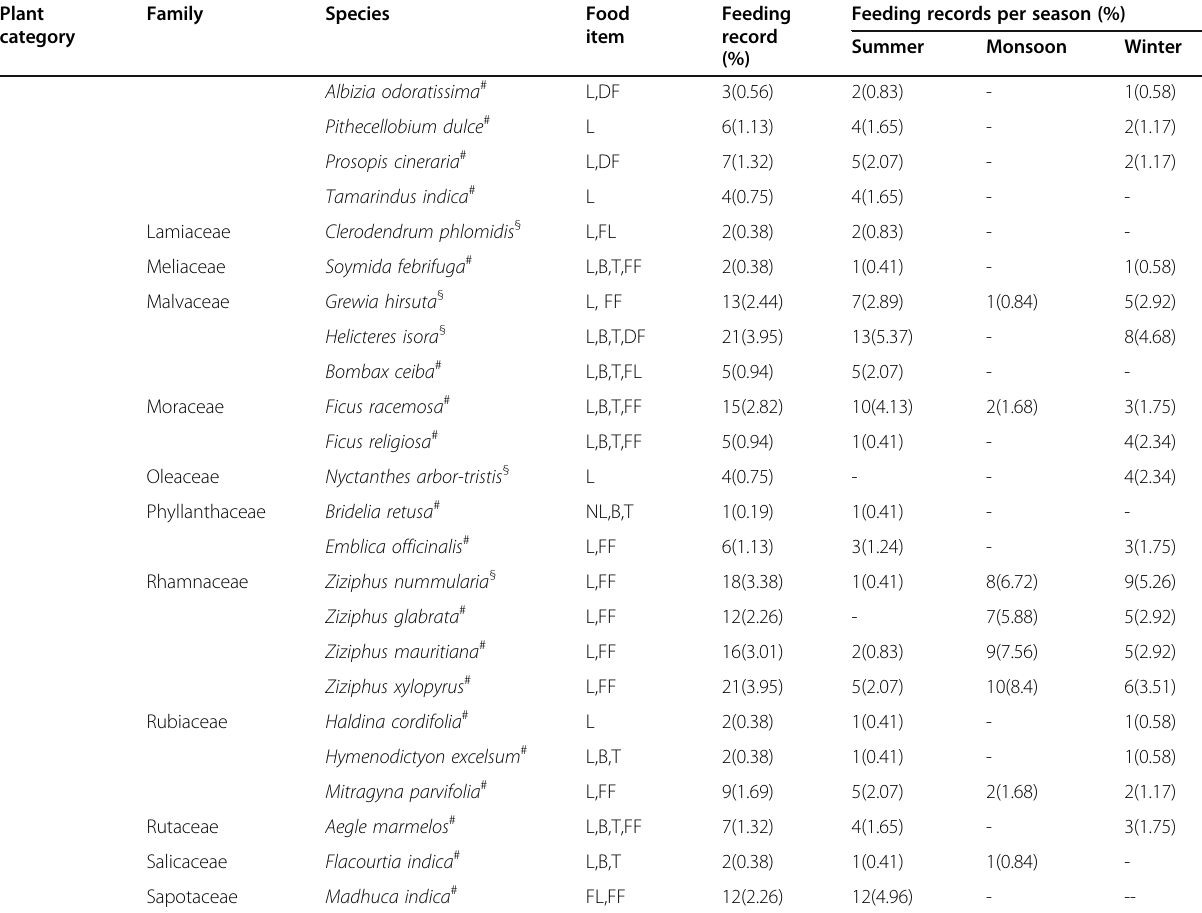
Table 5 Seasonal composition of Four-horned Antelope ( T. quadricornis ) diet in the tropical deciduous forest of southern Rajasthan, India (L= leaves, B=buds, T=twigs, FL=flower, FF=fleshy fruit, DF=Dry fruit/pod). Data is presented in number of feeding records (per- centage)